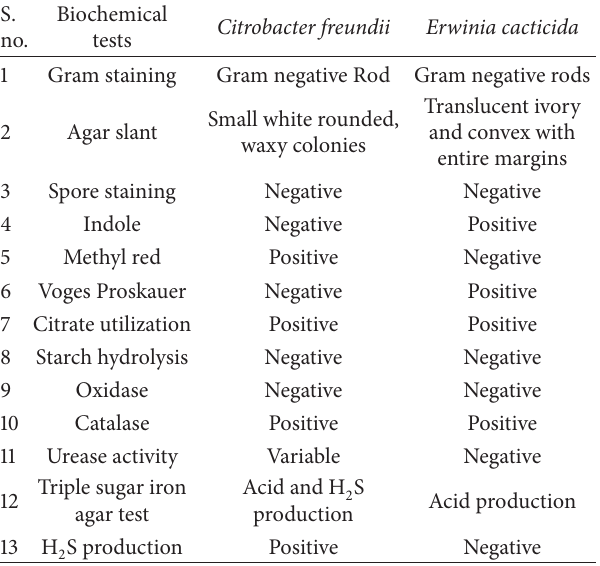
Table 1: Biochemical analysis of bacteria isolated from disease infected agricultural plant